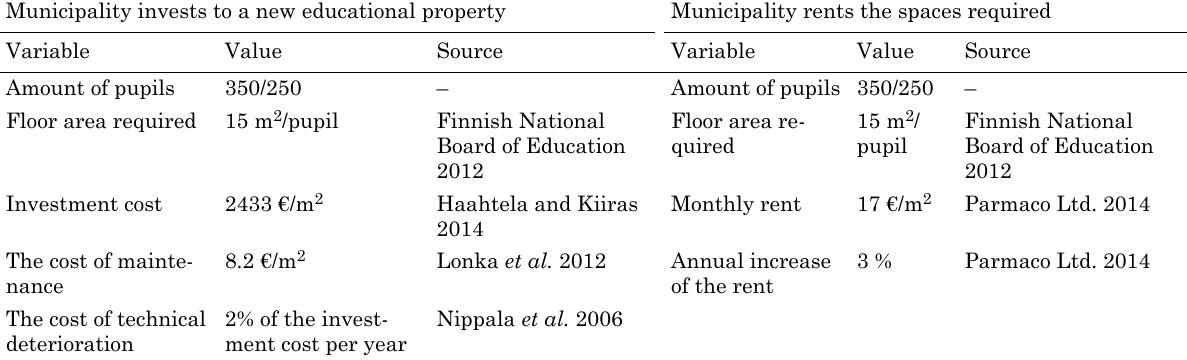
Table 3. The variables used in the LCC-analysis when comparing the two investment alternatives to arrange education spaces required from the perspective of a municipality municipality invests to a new educational property municipality rents the spaces required Variable Value source Variable